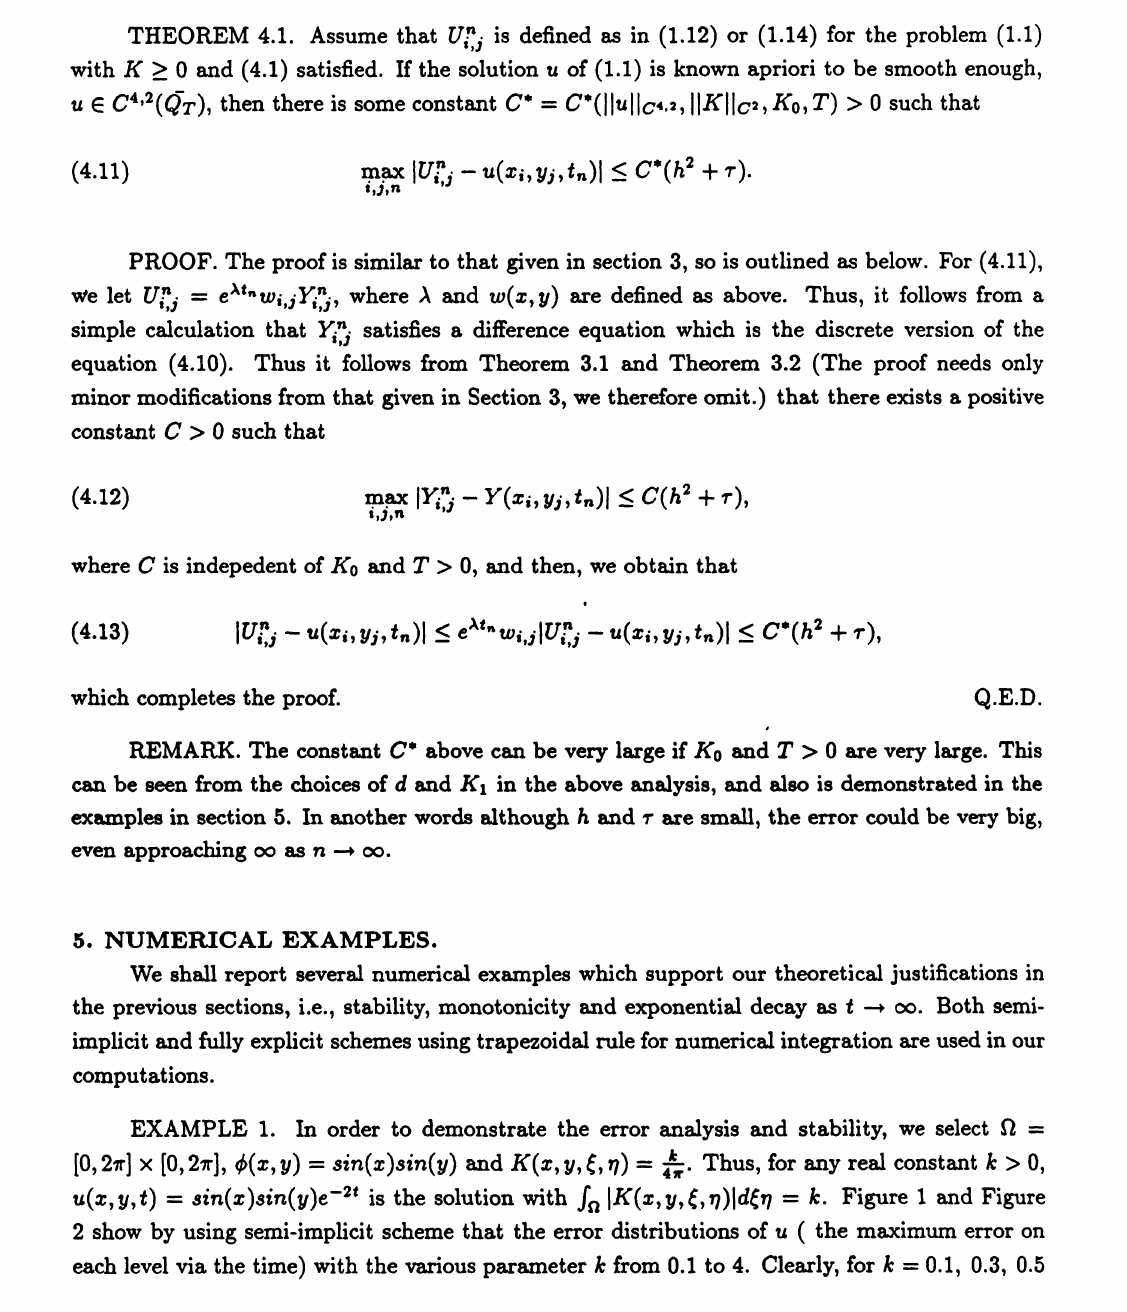
k. Figure 1 and Figure the maximum error on 0.1, 0.3,